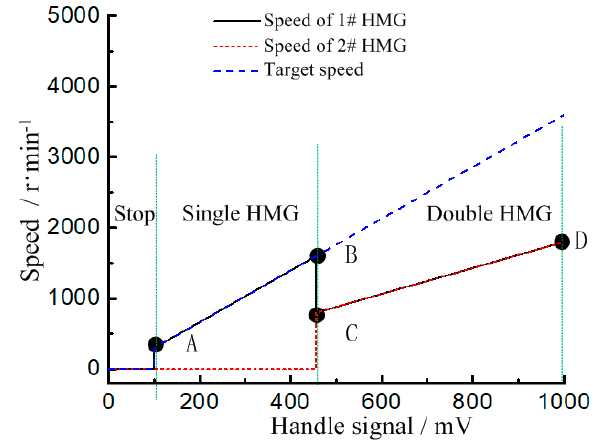
Figure 6. Relation diagram between the motor speed and handle opening.